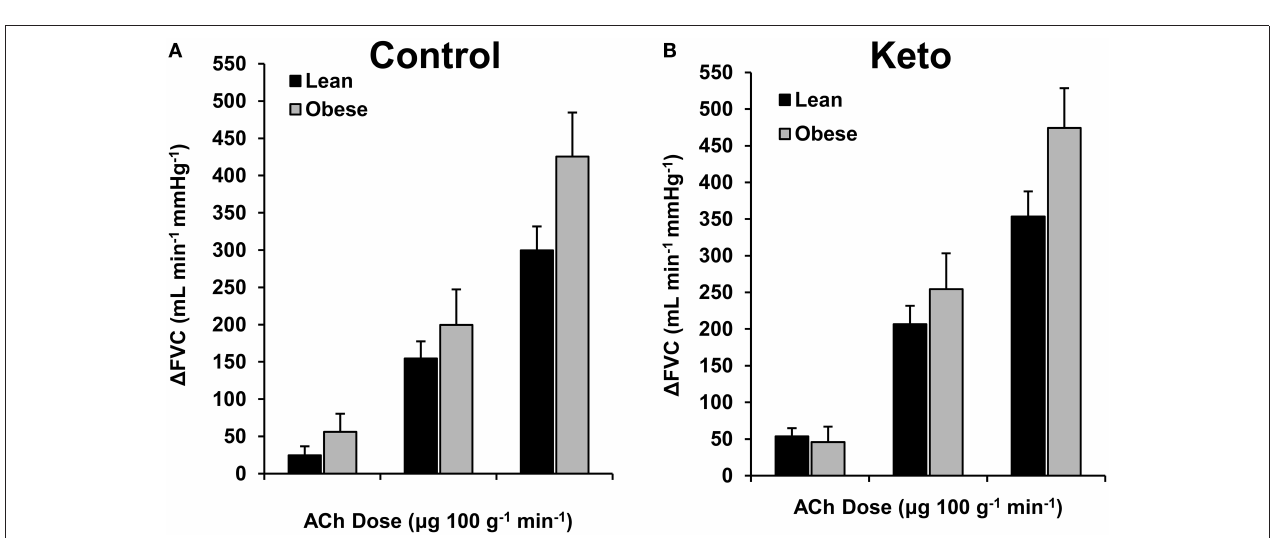
FIGURE 3 | ACh responses with Keto. Change in forearm vascular conductance ( (cid:2) FVC) with intra-arterial ACh infusion and cyclooxygenase inhibition (Keto). (A) (cid:2) FVC was not different between lean ( n = 26 ) and obese ( n = 7 ) adults. (B) (cid:2) FVC with Keto was not different between lean ( n = 26 ) and obese ( n = 7 )